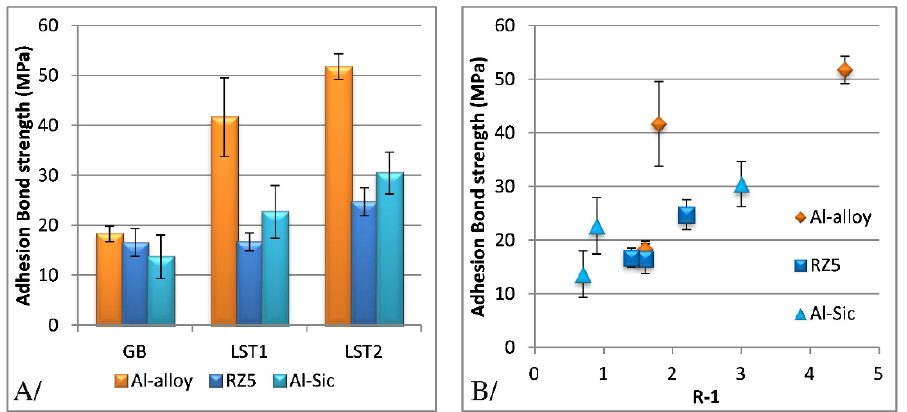
Figure 13. Adhesion bond strength as a function of surface preparation. ( A ) Grit-blasting (GB), texture 1 (LST1), and texture 2 (LST2). ( B ) Adhesion bond strength as a function of the in-contact area ratio for Al, Mg, and Al-SiC couples [86].